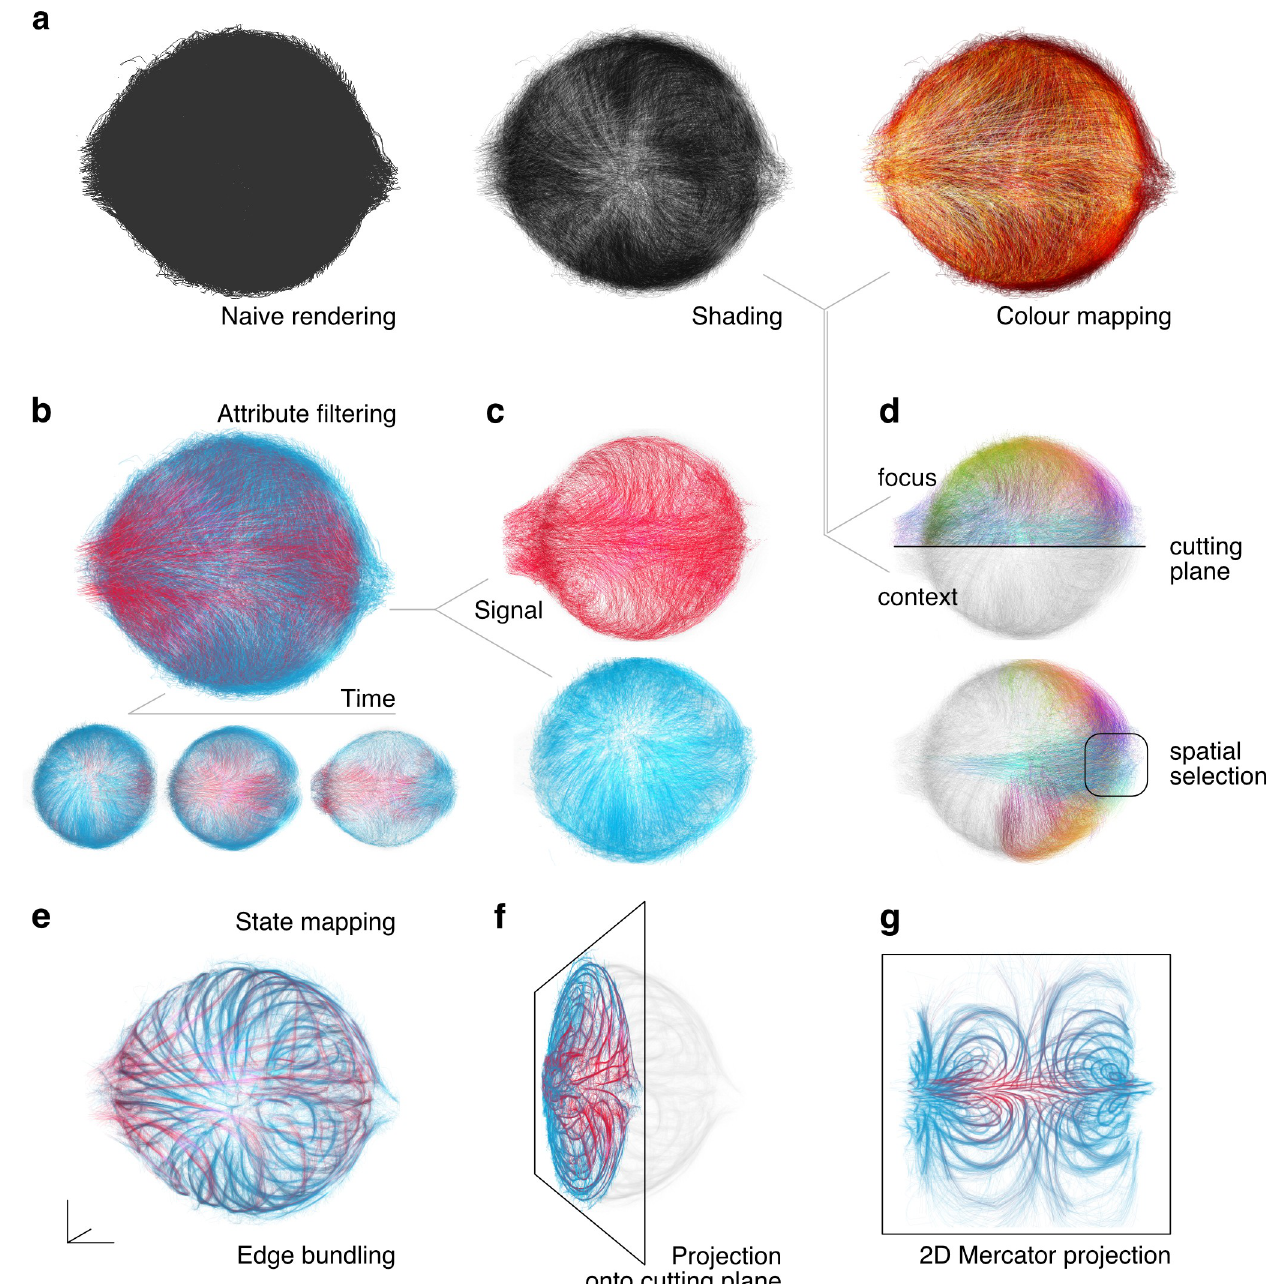
Fig 2. Configurable filters allow deep data exploration. The user can choose from a range of several visualisation methods directly in the browser interface to highlight aspects of interest in the data (zebrafish tracking results from [2] as an example). (a) The line data is visualised using a range of options for shading and colour mapping. (b-c) From the full dataset (top), the user can filter parts of the data concerning specific attributes, such as time intervals (bottom) or (c) a specific range of signals (marker expression in cells in this case). (d) The user can further create subselections of the tracks in space using cutting planes or refinable spatial selections. The visual attributes can be defined separately for the selected focus region and the non-selected context region. (e-g) The web interface can blend seamlessly between different states of the data. This feature can be used to map between (e) original tracks and their edge- bundled version, to visualise planar projections of the 3D data (f) locally on a definable (oblique) plane or (g) globally using a Mercator projection (with definable parameters).